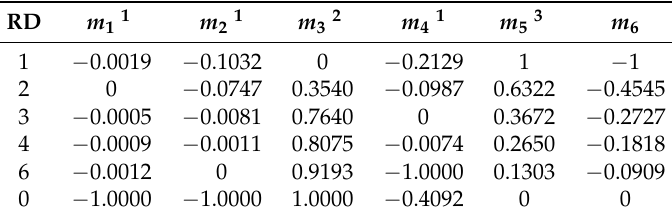
Table 4. Results of data preprocessing.